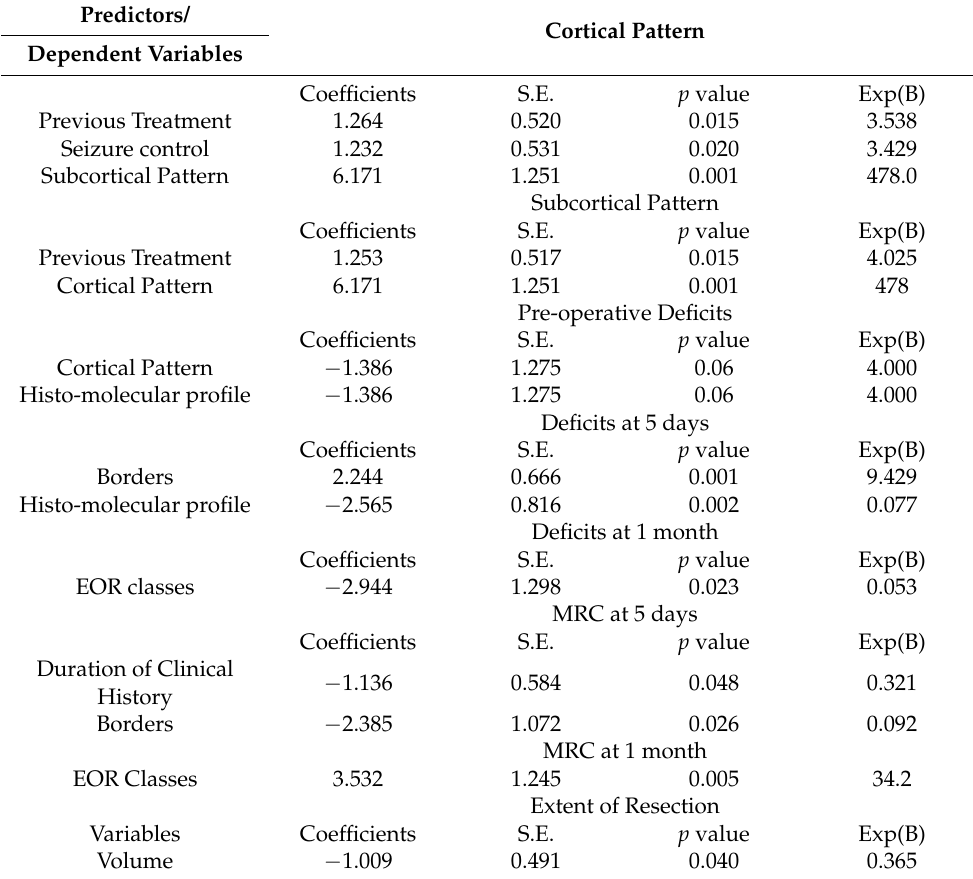
Table 3. Logistic regression. Significant predictors of Cortical Pattern, Subcortical Pattern, Motor per- formances at 5 days and 1 month, and Extent of resection. Histo-molecular profile (HGG); Duration of Clinical History (>6 m); Borders (Well-demarcated); EOR classes (Total vs.